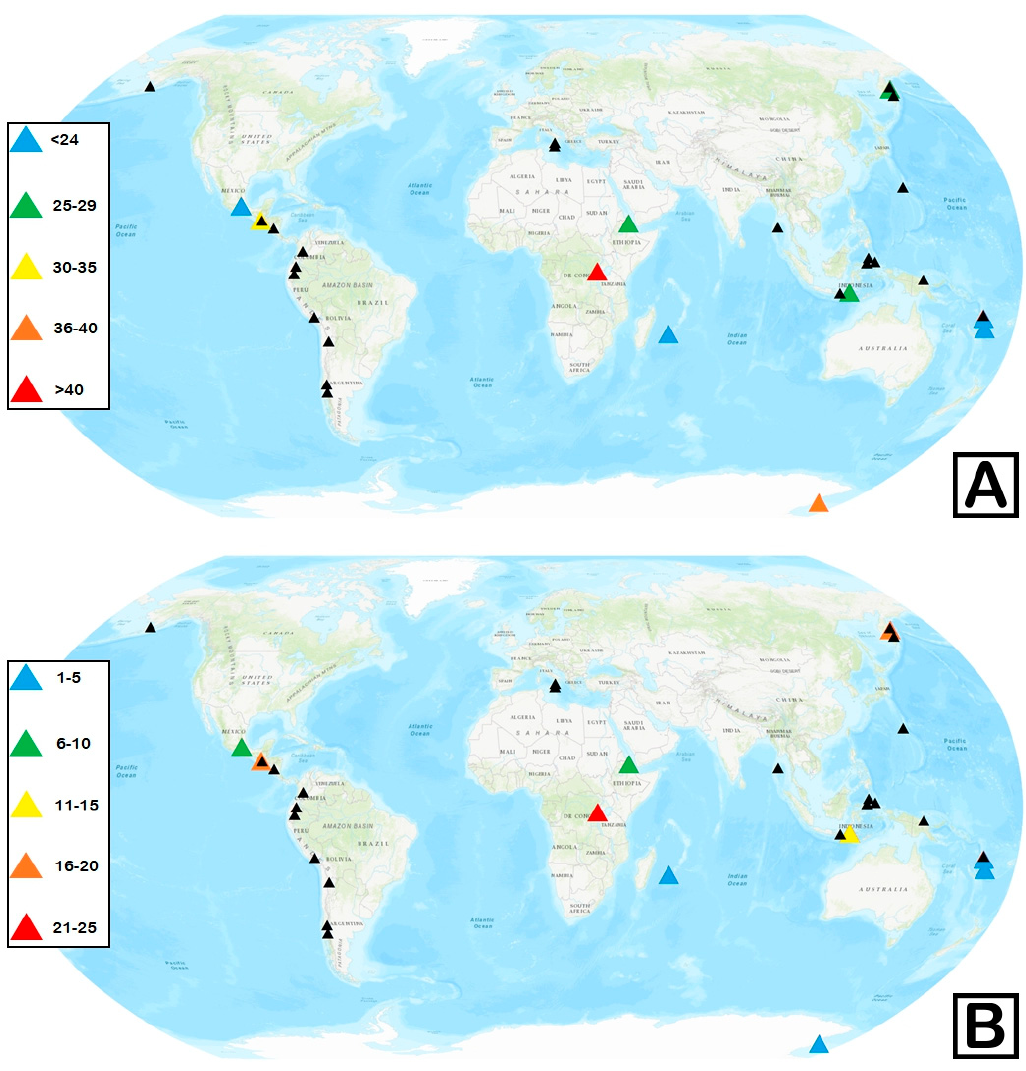
Figure 8. Map of the statistics for the 10 volcanoes detailed in Table 2, which were compiled over 1 year (1 June 2018 to 31 May 2019). Small black triangles indicate active URP-monitored volcanoes at the time, but not analyzed for this study. ( A ) Number of ASTER scenes acquired. ( B ) Number of those ASTER scenes with visible volcanic activity.